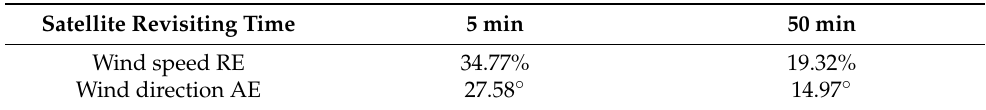
Table 5. The wind-tracking errors of the selected smooth area at 400 hPa with 5 min and 50 min revisiting